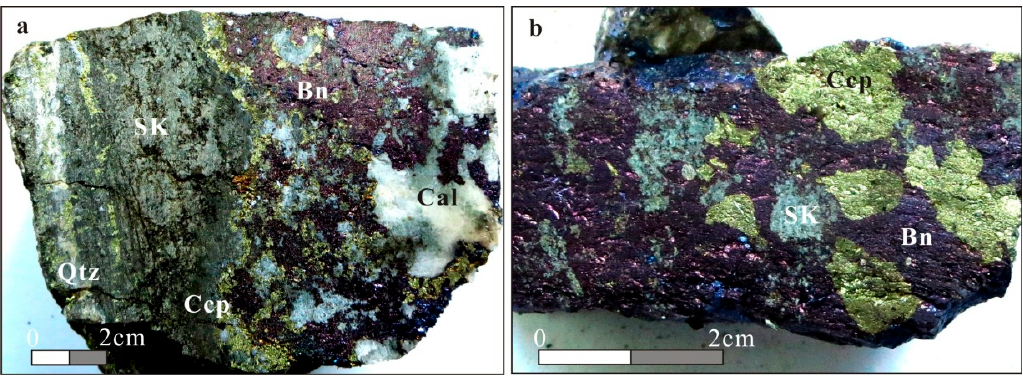
Figure 3. Photographs of bornite-chalcopyrite ore samples containing the zincian greenockite of the Saishitang Cu deposit. ( a ) Hand specimen of skarn-hosted ore, with bornite (Bn), chalcopyrite (Ccp), skarn minerals (SK), quartz (Qtz), and calcite (Cal); ( b ) massive ore, with chalcopyrite in the bornite. Note the subrounded boundaries of the chalcopyrite.